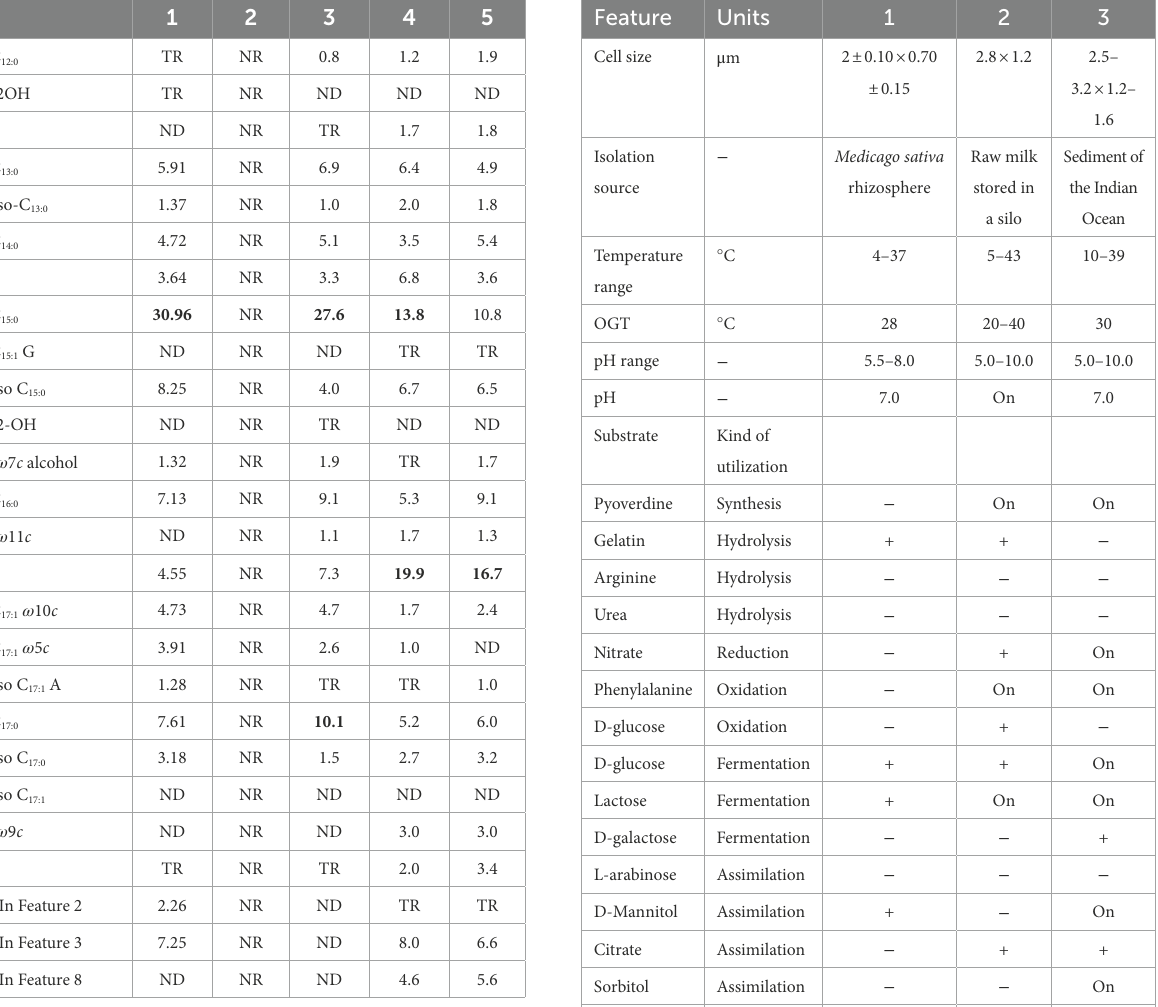
TABLE 8 Differential characteristic phenotype of SAICEU11 T and closely related Bacillus species.